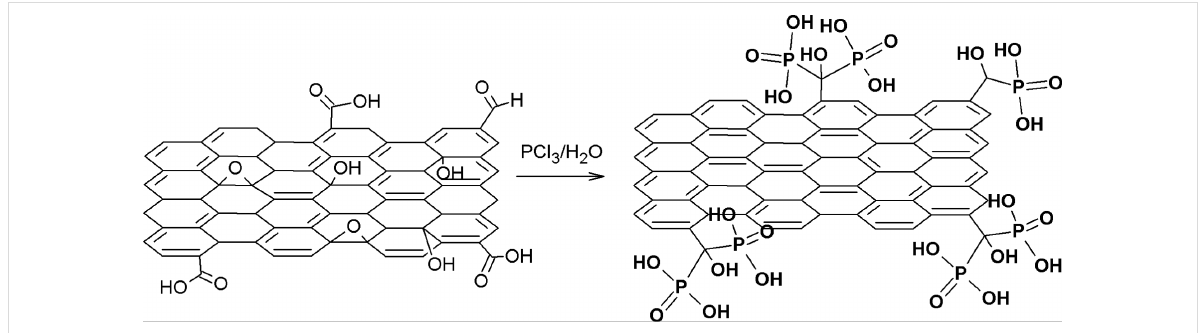
Figure 1: Scheme of GO-P